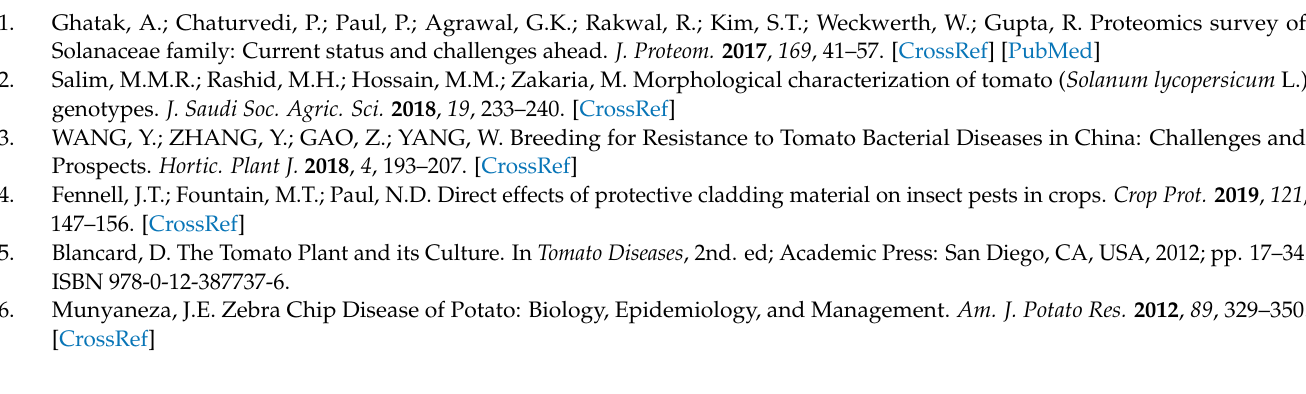
Figure S3: Healthy plants of tomato ( Solanum lycopersicum ) at 21 days of treatment with 70 ppm of PNB (PNB) and water treated (Control). Plants were grown in greenhouse conditions in absence of Bactericera cockerelli and Candidatus Liberibacter solanacearum. Figure S4: Infected plants of tomato ( Solanum lycopersicum ) with Candidatus Liberibacter solanacearum ( Ca Lso) at 7 days of treatment with 70 ppm of PNB. Figure S5: Infected plants of tomato ( Solanum lycopersicum ) with Candidatus Liberibacter solanacearum ( Ca Lso) at 14 days of treatment with 70 ppm of PNB. Figure S6: Infected plants of tomato ( Solanum lycopersicum ) with Candidatus Liberibacter solanacearum ( Ca Lso) at 21 days of treatment with 70 ppm of PNB and